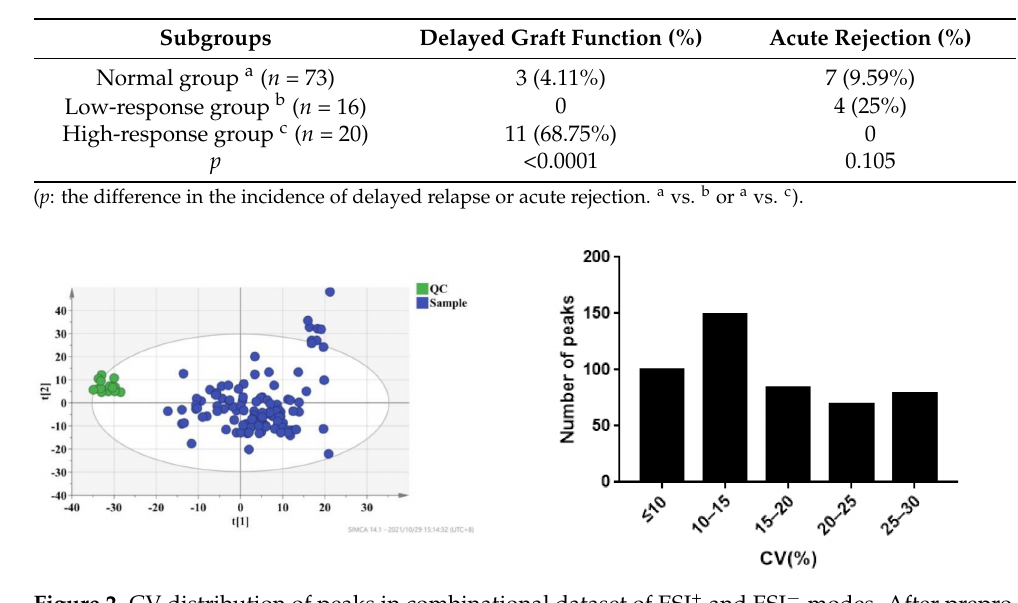
Figure 2. CV distribution of peaks in combinational dataset of ESI + and ESI − modes. After prepro- cessing the data, all peaks had coefficients of variation (CVs) below